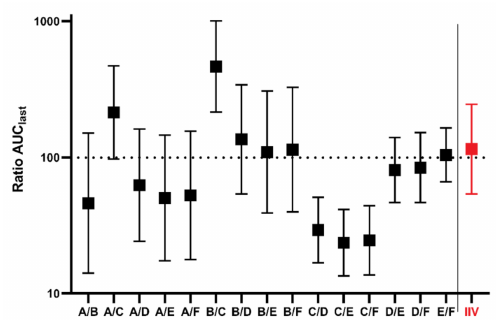
Figure 2. Results of bioequivalence evaluations, and AUC last ratios with 90% CI between groups A–F in parallel design. To the right of the division line is the group IIV AUC last ratio to compare periods from cross-over design. Log scale was used on y